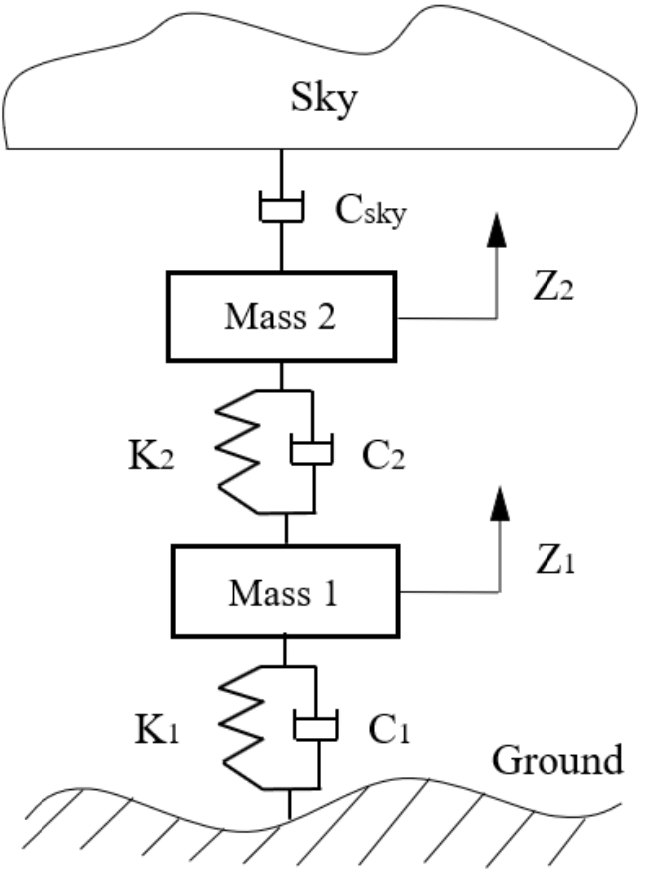
Figure 5. Abridged general view of sky-hook control.